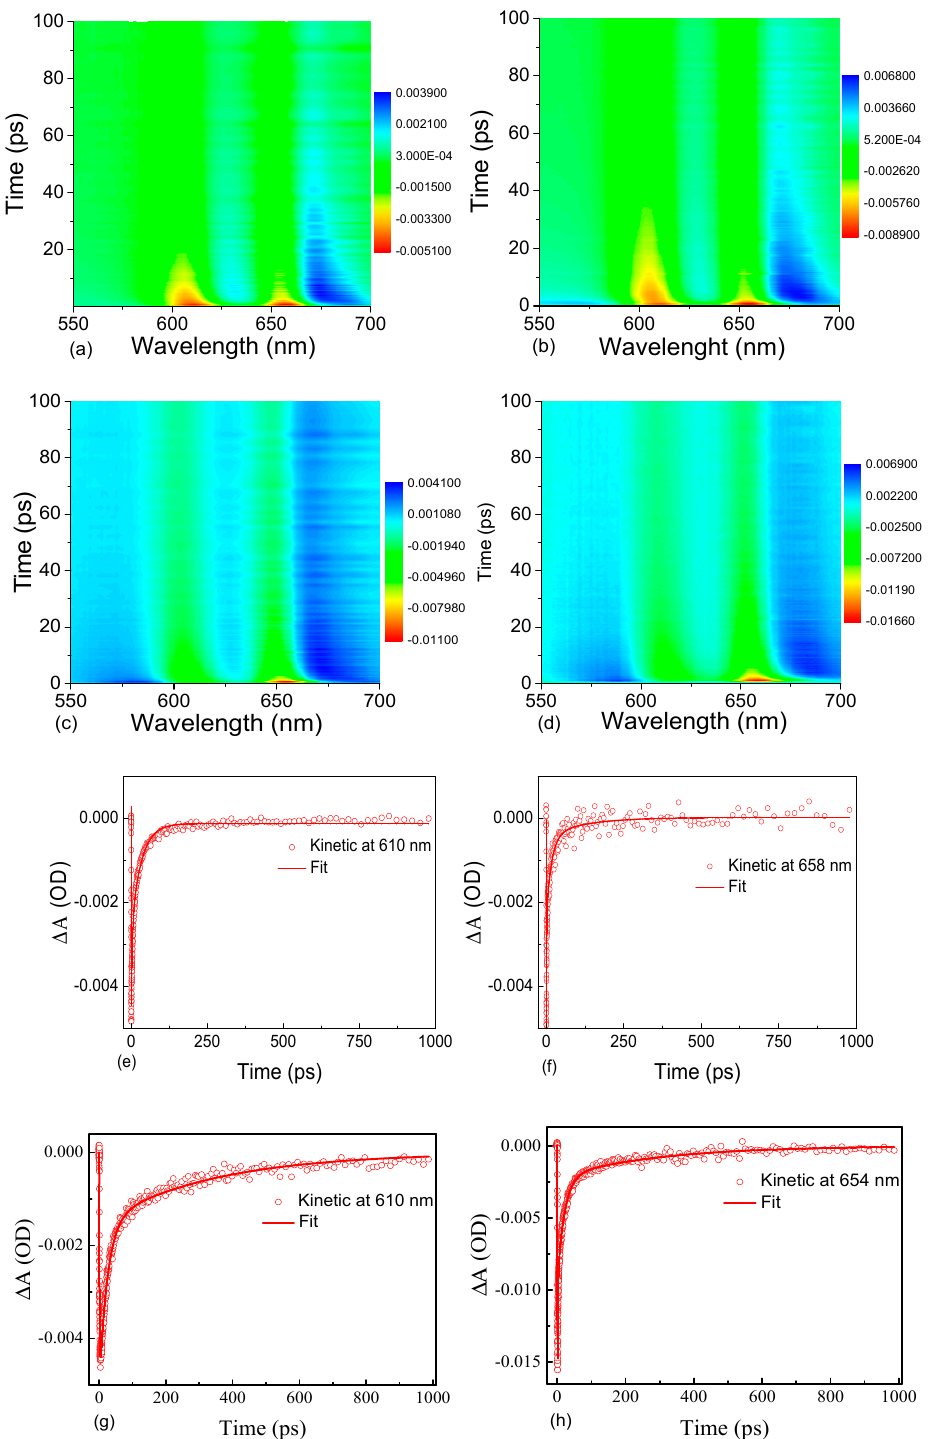
Figure 4. The ultrafast transient absorption spectra of ( a ) monolayer MoS 2 , and ( b – d ) monolayer MoS 2 -Ag NPs hybrid system where sizes of Ag NPs are 6.1, 14.5 and 21 nm, respectively. The transient absorption spectra of ( e , f ) monolayer MoS 2 fitted at excitonic state A and B respectively, and ( g , h ) monolayer MoS 2 -Ag NPs hybrid fitted at excitonic state A and B respectively, where the size of Ag NPs is 21 nm [105].